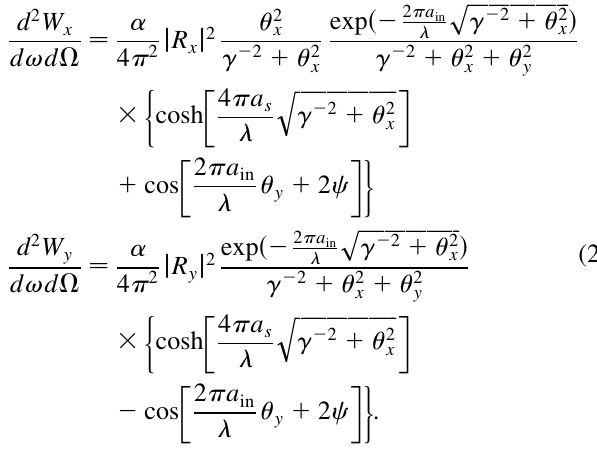
(cid:5) 70 (cid:8) m , dashed line; and s (cid:5) 0 : 185 mm , (cid:6) (cid:5) 45 (cid:14) , and j R j 2 (cid:5) y in 0